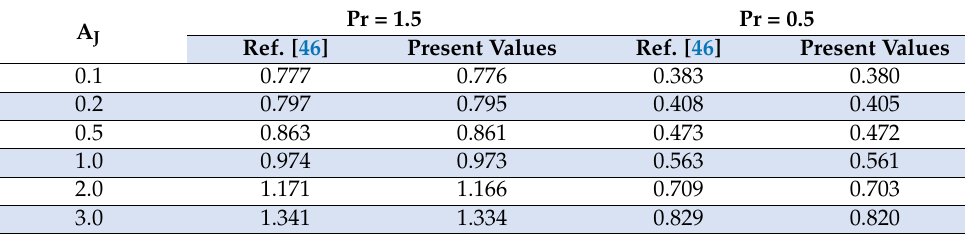
Table 6. Comparison for Nusselt when K = E J = λ M = B J = R = S = H ± = 0. Pr =